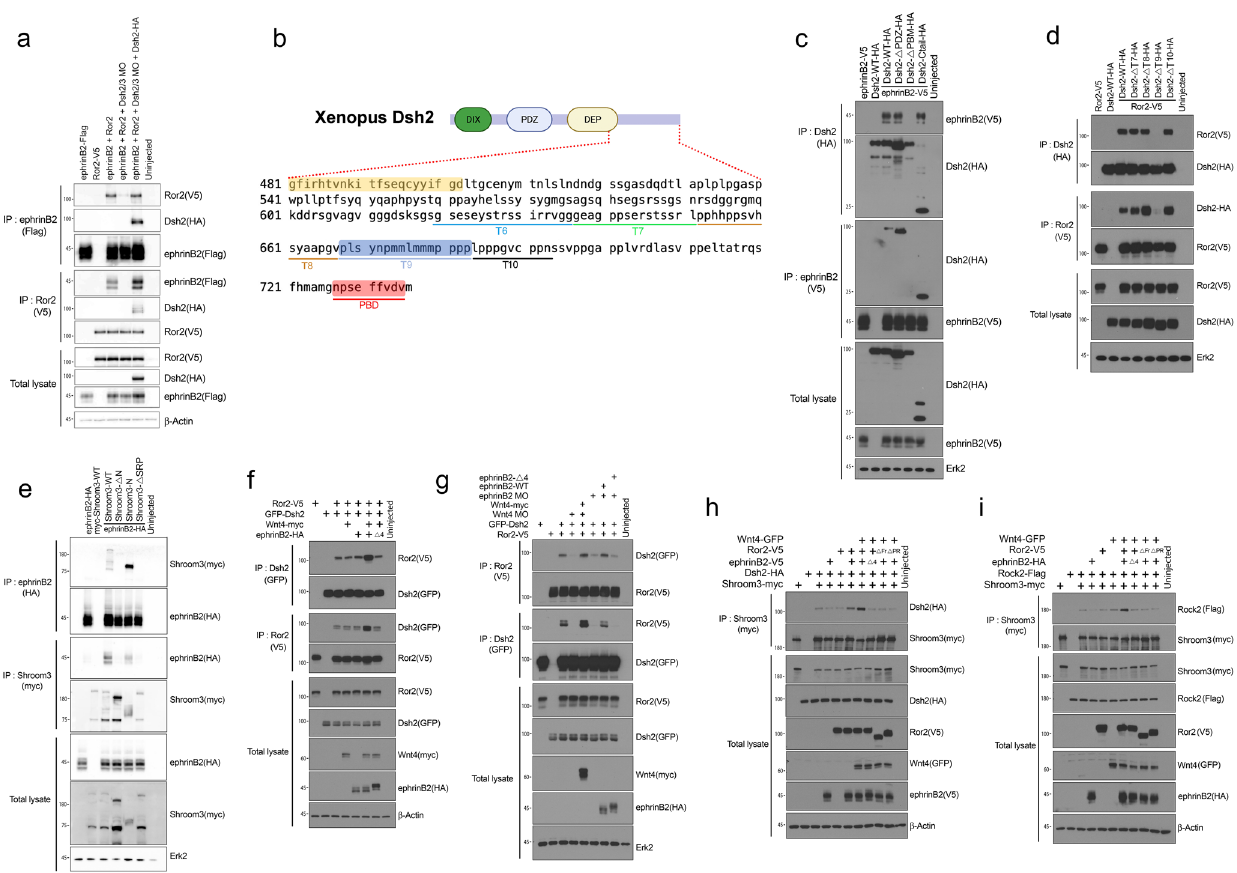
Fig. 4 | Wnt4, ephrinB2, Ror2, Dsh2, and Shroom3 form a signaling complex. a Co-IP assay with ephrinB2 (100pg) and Ror2 (100pg) in Dsh2/3 morphants. b Schematic of Dsh2 serial deletion in the tail region (Ctail). c Co-IP assay with ephrinB2 (500pg) and Dsh2 (1ng)deletion mutants. d Co-IP assaywith Ror2 (1ng) and Dsh2 (1ng) deletion mutants. e Co-IP assay with ephrinB2 (500pg) and con- serveddomaindeletionmutantsofShroom3(1ng). f Co-IPassaywithRor2(100pg)